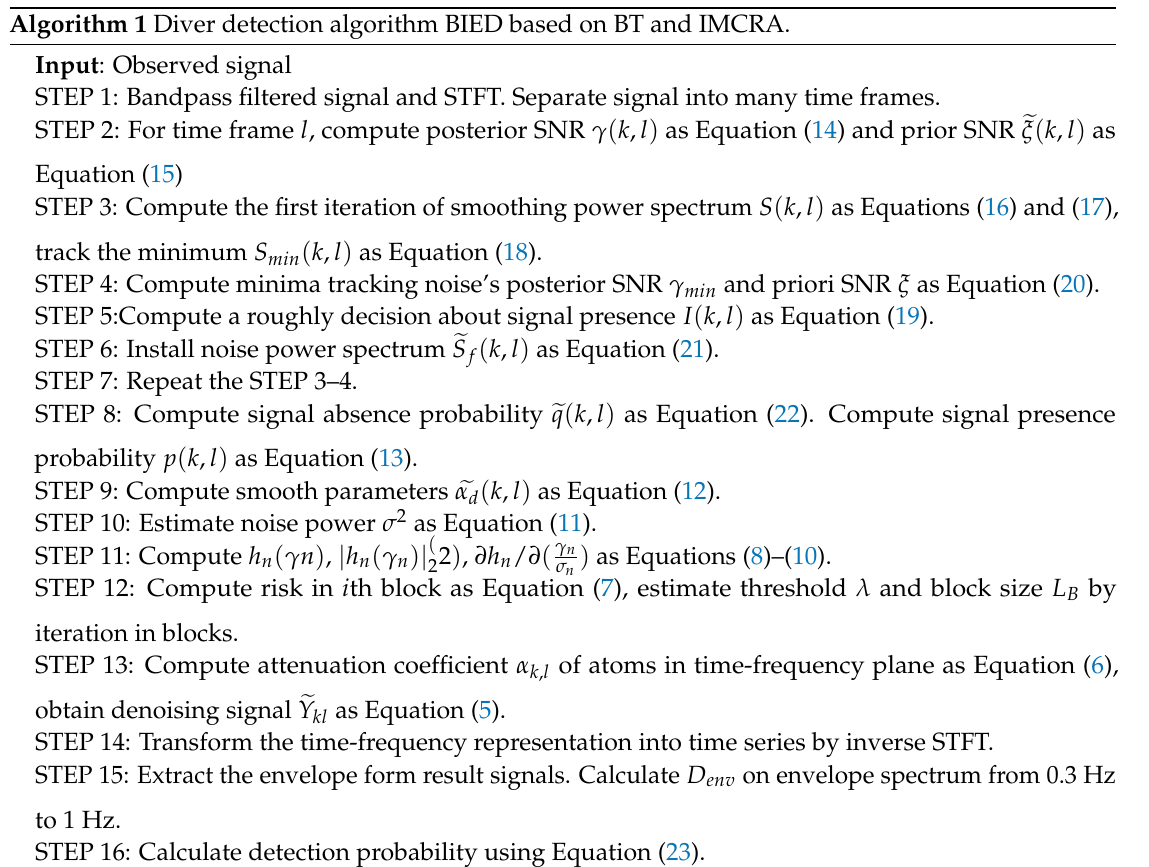
Algorithm 1 Diver detection algorithm BIED based on BT and